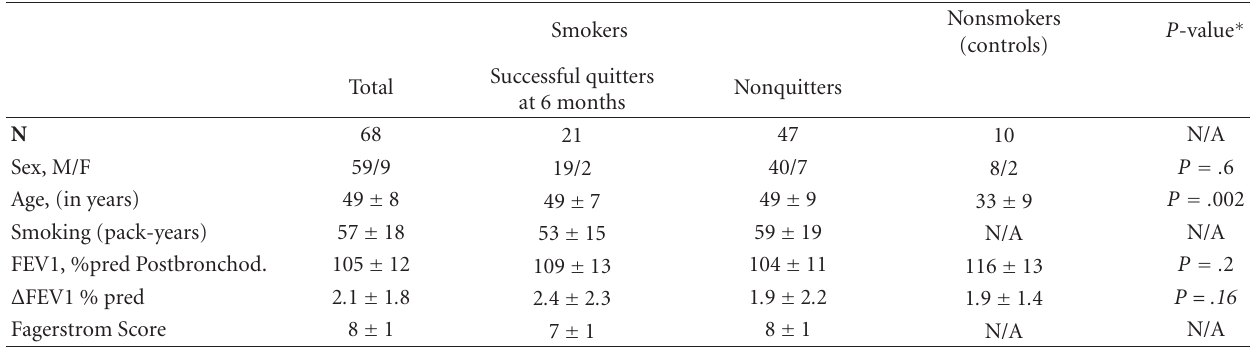
Table 1: Subject characteristics.